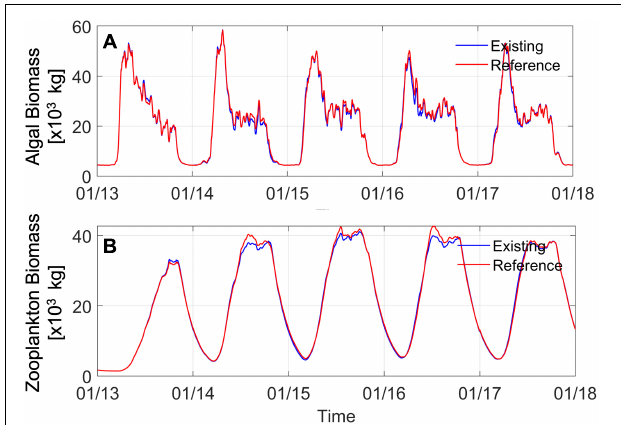
FIGURE 10 | Time series of (A) algal (phytoplankton) biomass and (B) zooplankton biomass from the south Salish Sea region including Puget Sound, Strait of Juan de Fuca, and Georgia Strait south of the U.S.-Canada border. The blue line represents model results for the existing condition including the marine heatwave warming. The red line represents reference conditions without marine heatwave-related warming.